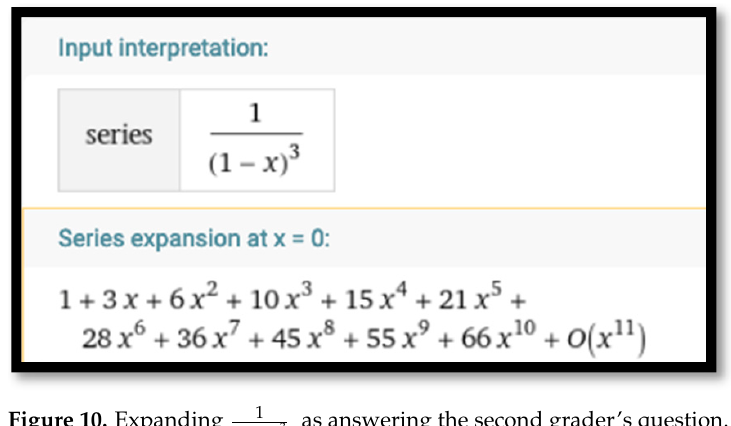
Figure 10. Expanding